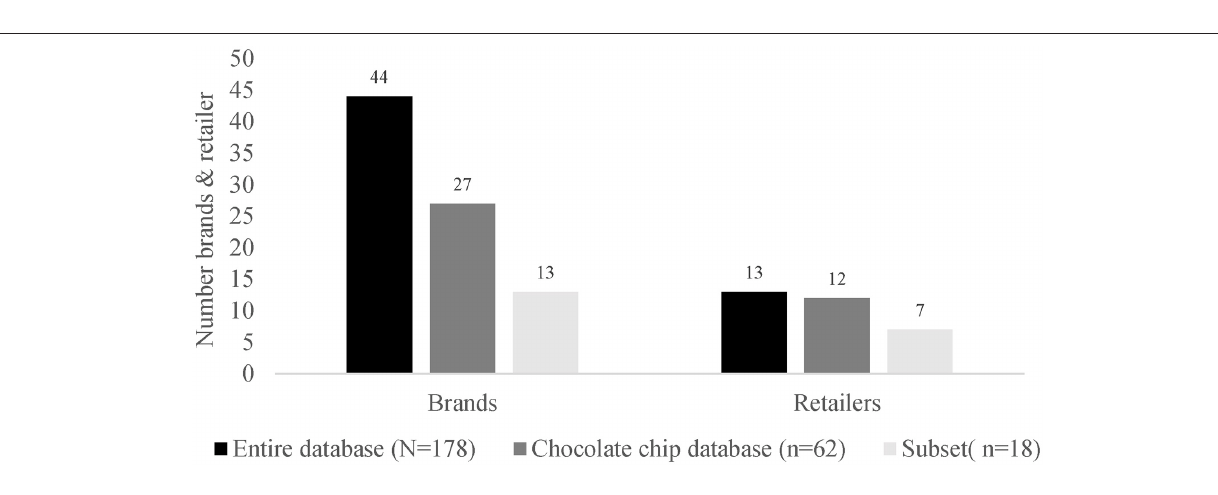
for almost all variables. The subset led to a slightly different distribution for the kcal, fiber, protein, salt, and water content. The subset also accounted for minimal and maximum values for most of the